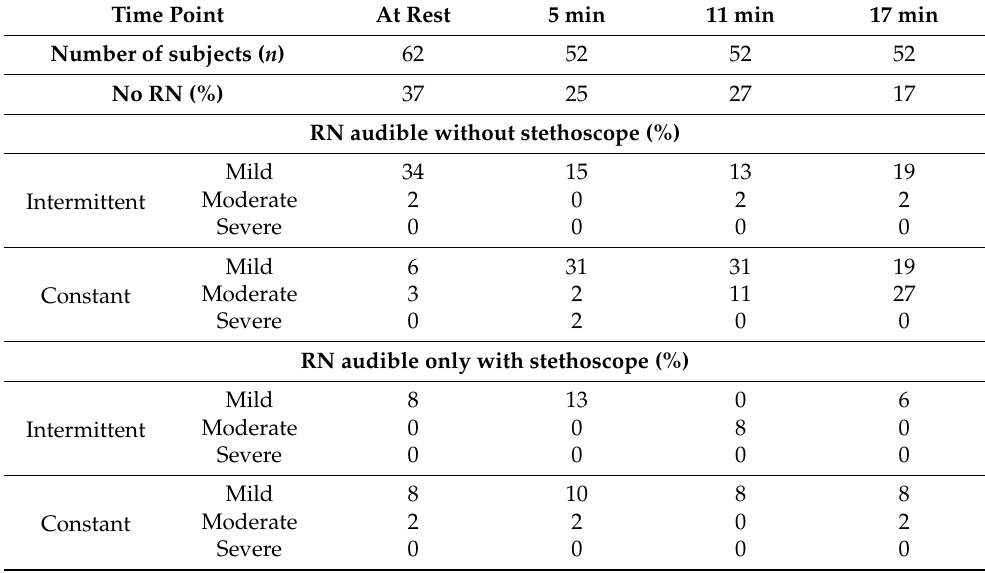
Table 2. Respiratory noises (RN) of pugs at rest and during exercise.